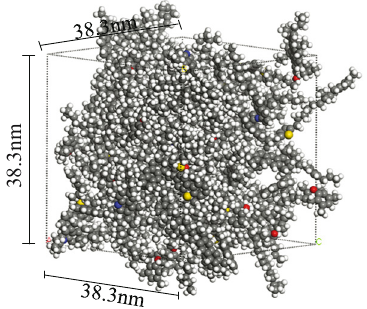
Figure 2: Asphalt molecular